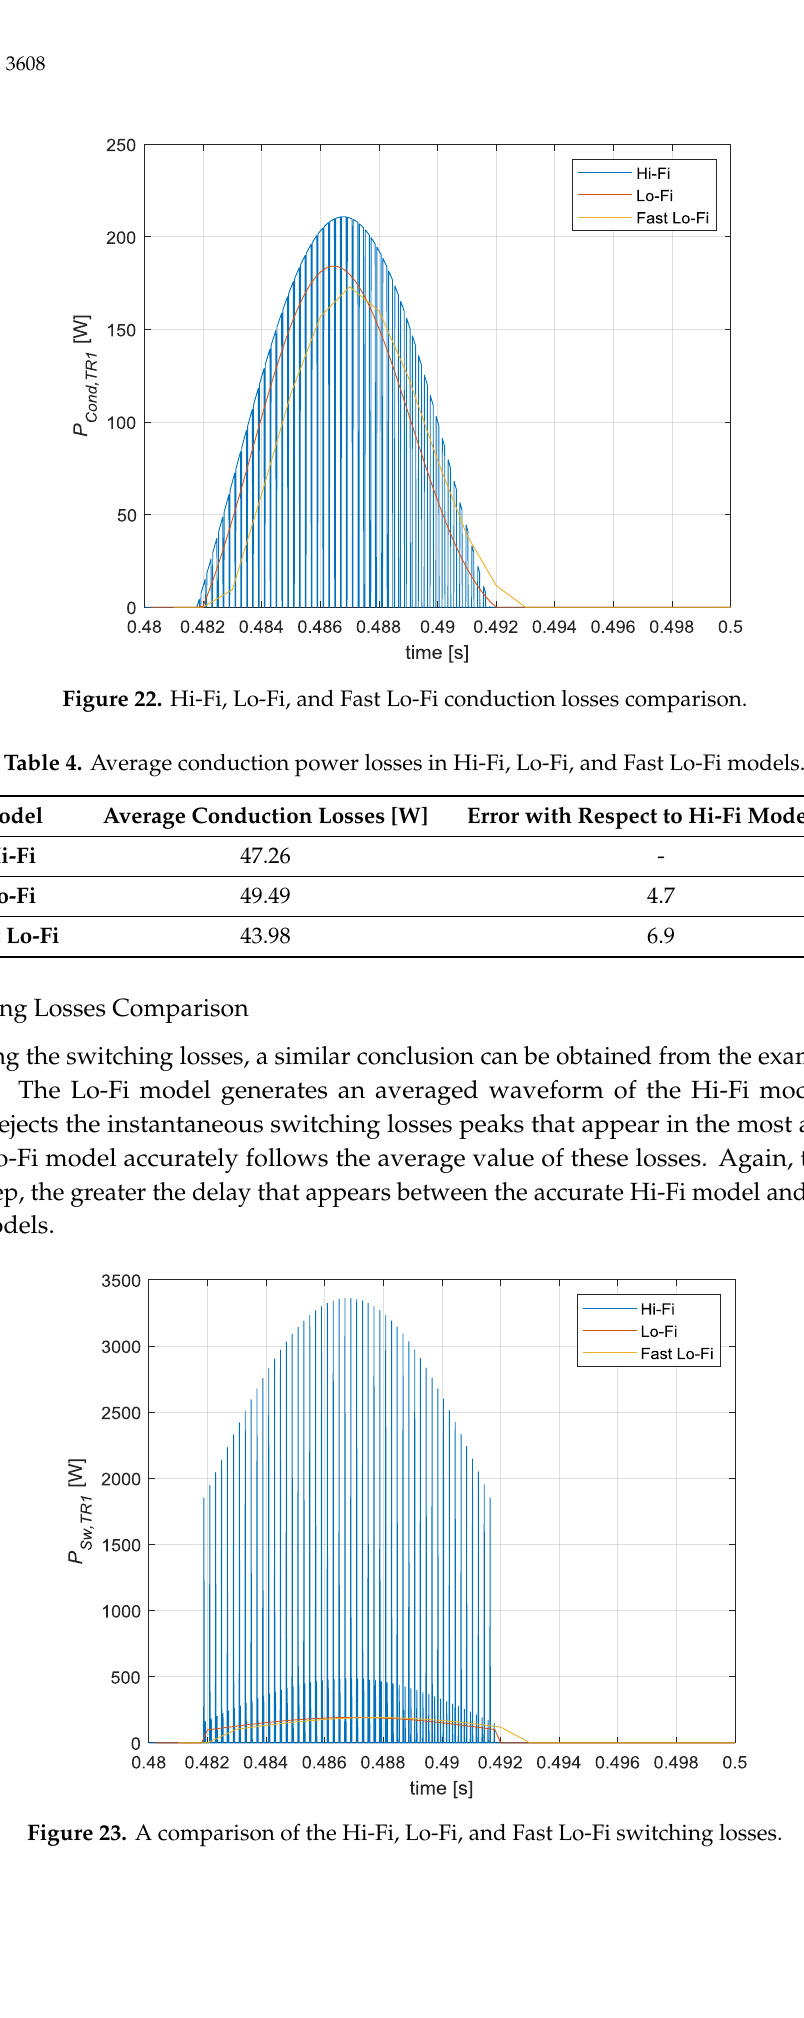
Table 5. Average switching power losses in the Hi-Fi, Lo-Fi, and Fast Lo-Fi models. Model